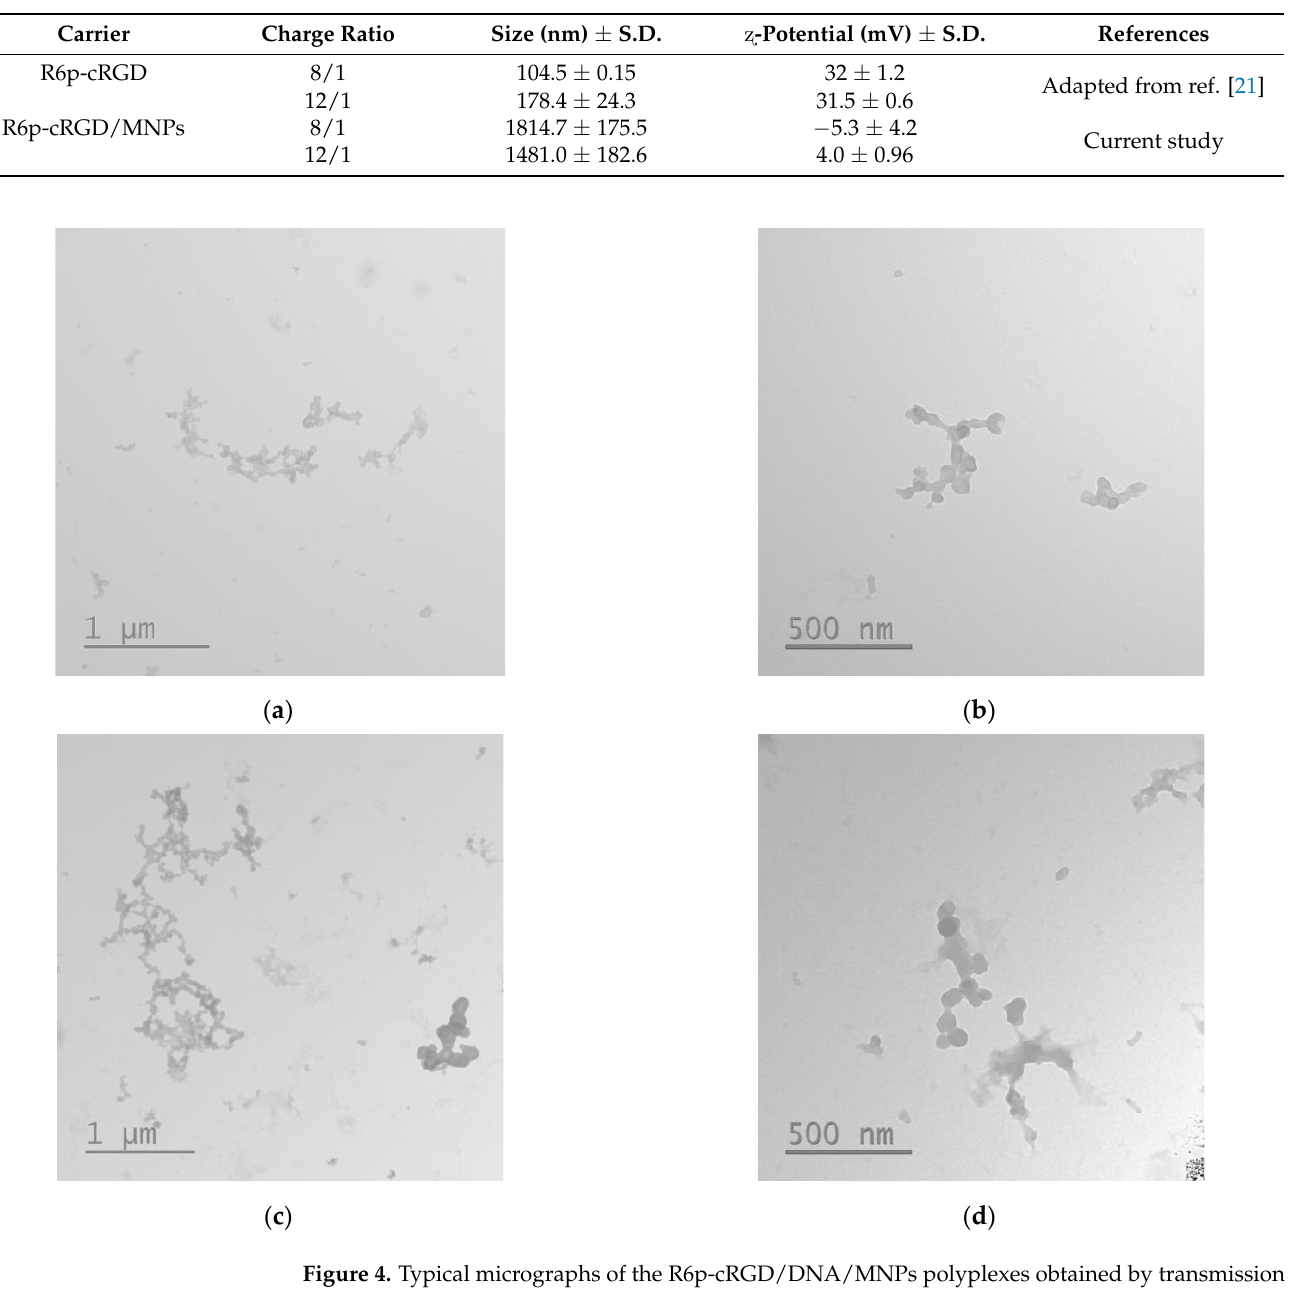
Table 1. Size and ü -potential of the R6p-cRGD/DNA/MNPs polyplexes.